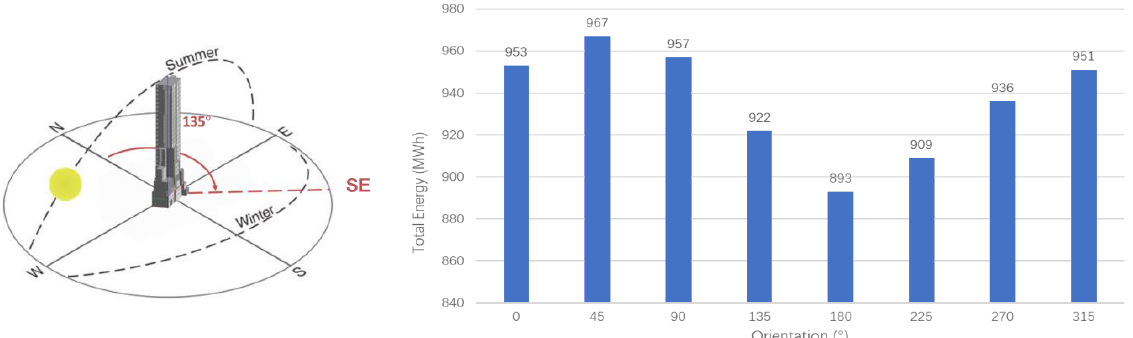
Figure 9. Total annual consumption of Model 1 in different orientations.